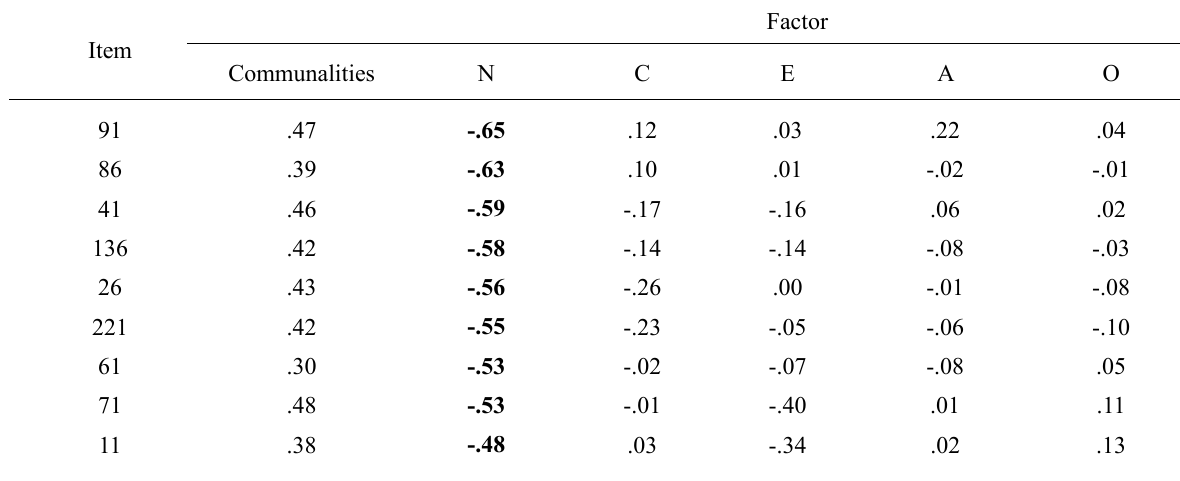
Principal Axis Factors with Direct Oblimin Rotation Solutions of NEO-FFI Items for Secondary and Tertiary Education Item